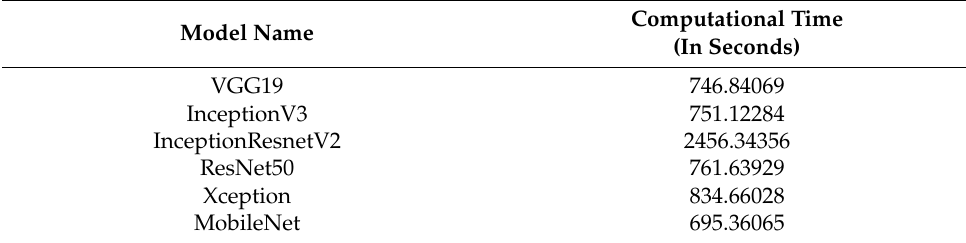
Table 8. Computation